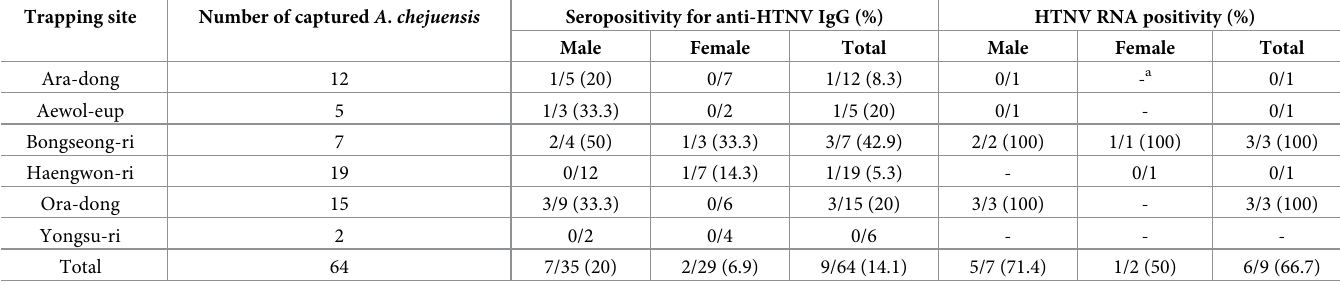
Table 2. Serological and molecular prevalence of Hantaan virus (HTNV) in Apodemus chejuensis captured on Jeju Island from 2018 to 2020. Trapping site